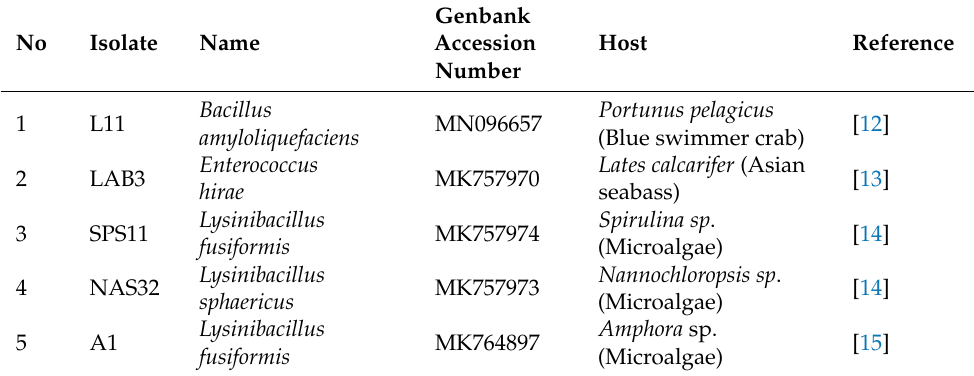
Table 1. Single-strain probiotics (SSPs) isolated from various aquatic hosts.